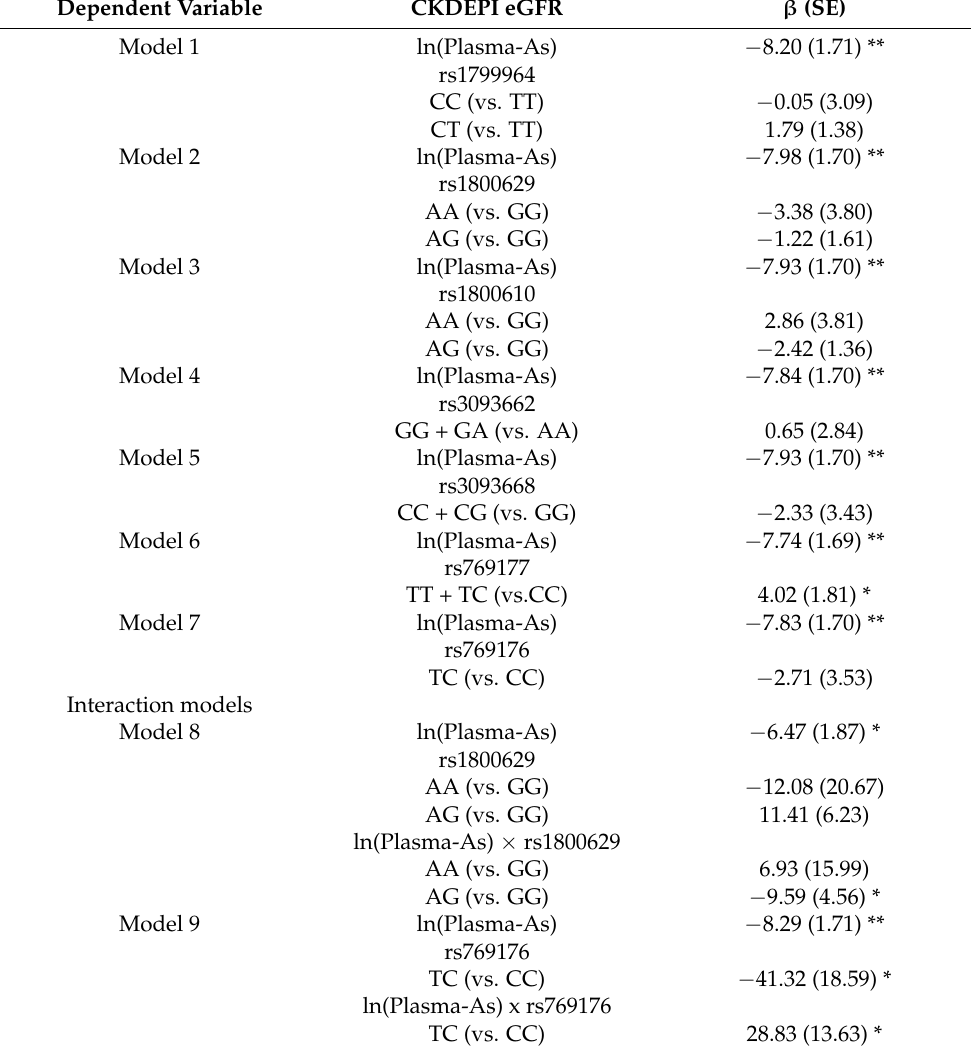
Table 4. Summary of multiple regressions of for effect of plasma arsenic (As) and SNPs of TNF- α (different SNPs in models 1 to 9) on kidney function (CKDEPI eGFR), with all adjusted for BMI, diabetes, hypertension, hyperlipidemia, kidney stones, and smoking habits. Dependent Variable CKDEPI eGFR β (SE) Model